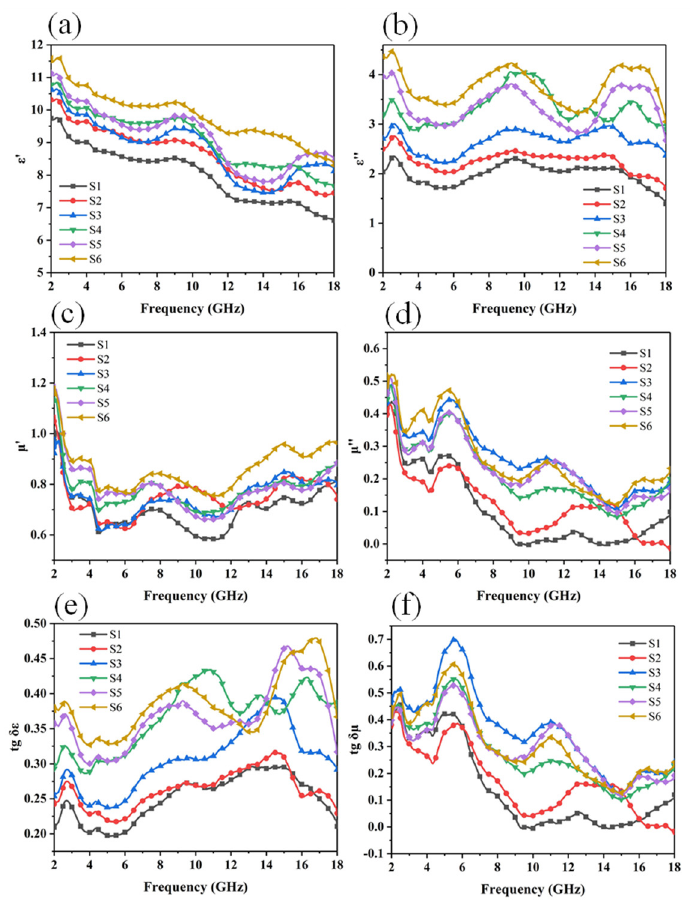
Figure 7. ( a ) ε (cid:48) change curve within 2–18 GHz of three-layer magnetic foam; ( b ) ε (cid:48)(cid:48) change curve; Figure 7. ( a ) ε ’ change curve within 2–18 GHz of three-layer magnetic foam; ( b ) ε ” change curve; ( c ) μ ’ change curve; ( d ) μ ” change curve; ( e ) tg δε change curve; ( f ) tg δμ change curve. ( c ) µ ’ change curve; ( d ) µ (cid:48)(cid:48) change curve; ( e ) tg δε change curve; ( f ) tg δµ change